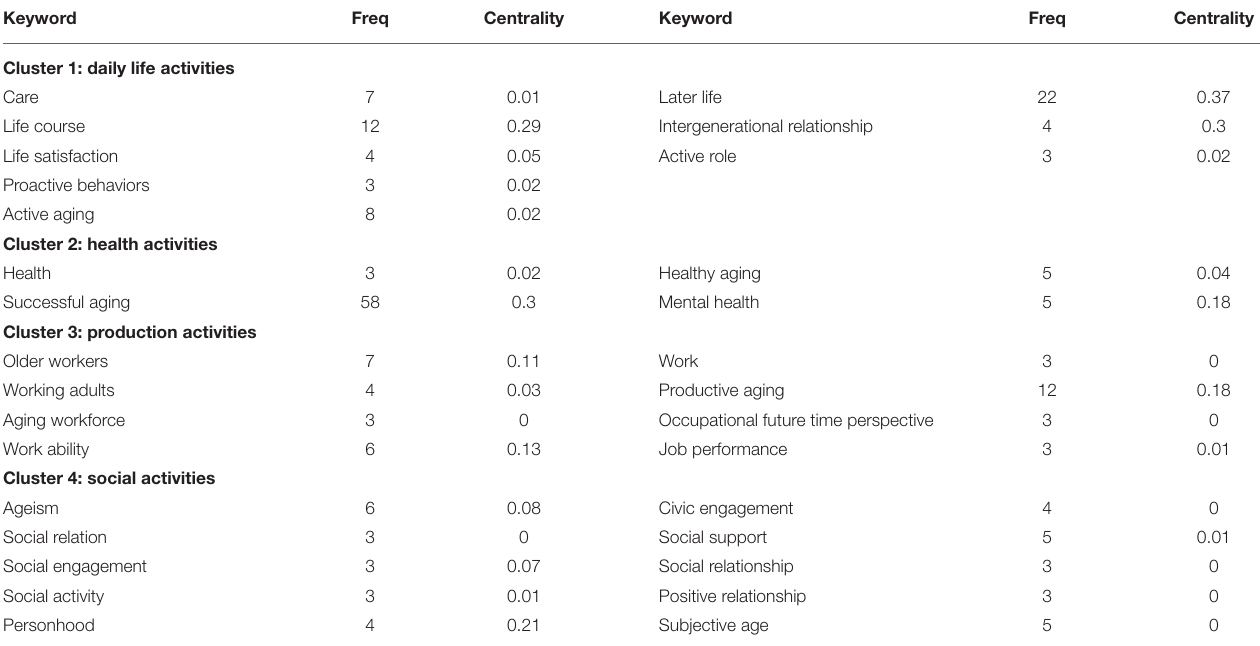
TABLE 4 | Successful aging and productive